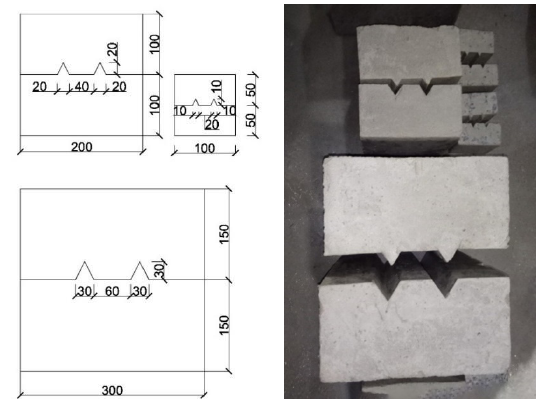
Figure 14: Double saw-tooth joint specimens with different